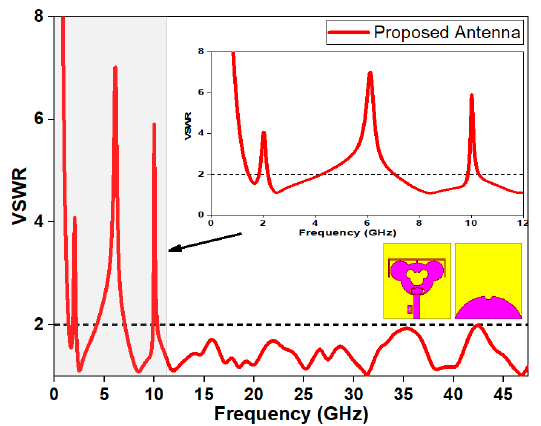
Figure 4. Phase 3: VSWR of the dual band-notched antenna.